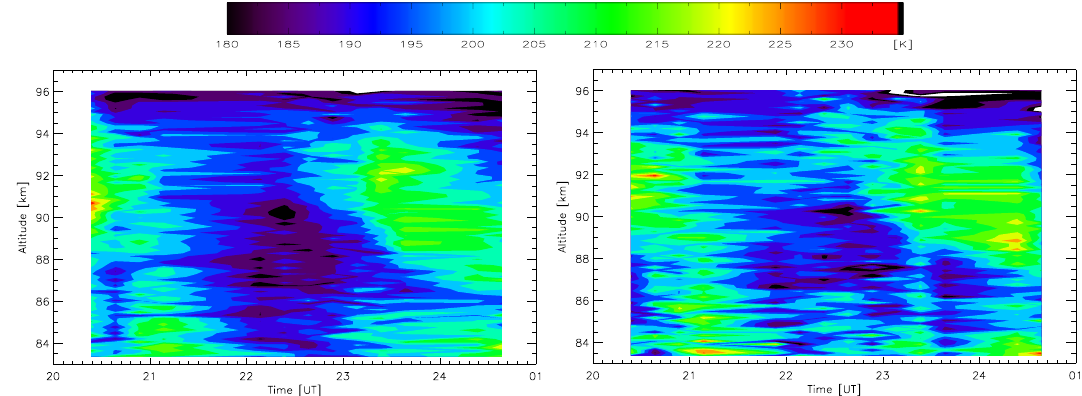
Fig. 7. Contour plots of 15min averaged temperatures from the ALOMAR Weber Na lidar on 5–6 November 2005. Beam 1 (left) is pointing 20 ◦ W of zenith. Beam 2 (right) is pointing 20 ◦ E of zenith.